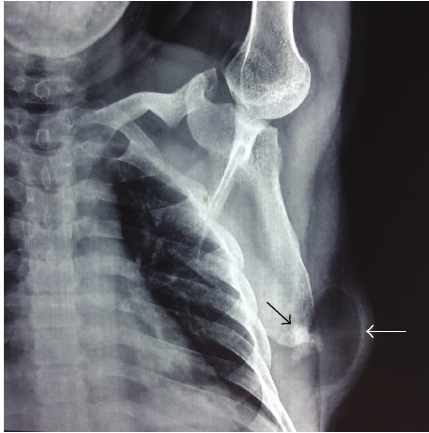
Figure 1: Plain radiograph of left shoulder joint showing a radi- olucent lesion (white arrow) with underlying irregular osseous protuberance (black arrow) arising from the inferior tip of scapula.